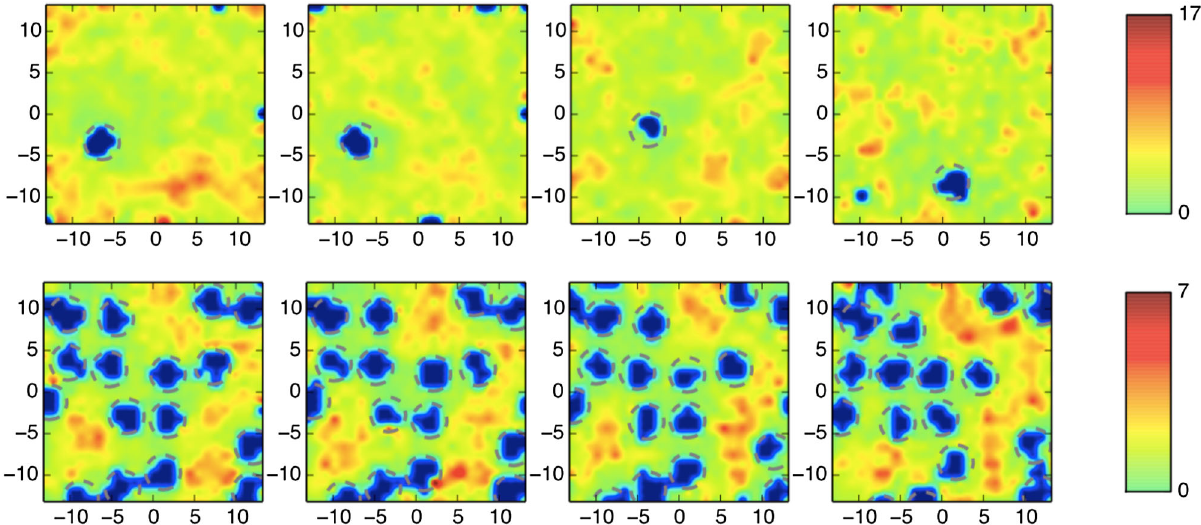
FIG. 7. Diffusion maps of DPPC lipid molecules in protein-poor (top) and protein-rich (bottom) membranes. In each case the four plots depict the diffusion maps at t ¼ 1 , 10, 100, and 1000 ns from left to right. Blue regions are the unoccupied space by the lipid at the given time, while the gray dashed circles illustrate the position of the proteins. Axis coordinates are in